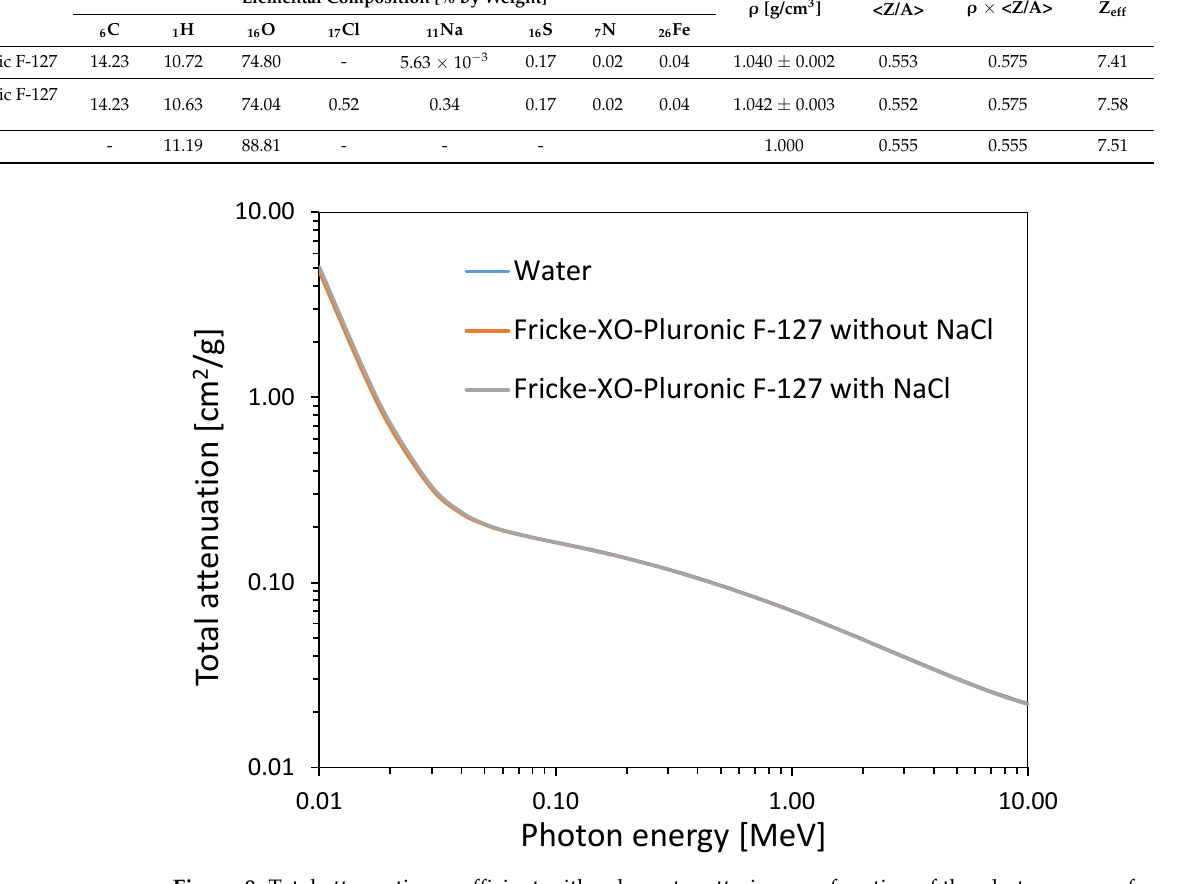
Figure 8. Total attenuation coefficient with coherent scattering as a function of the photon energy for water and Fricke-XO-Pluronic F-127 without and with 0.2 M NaCl.